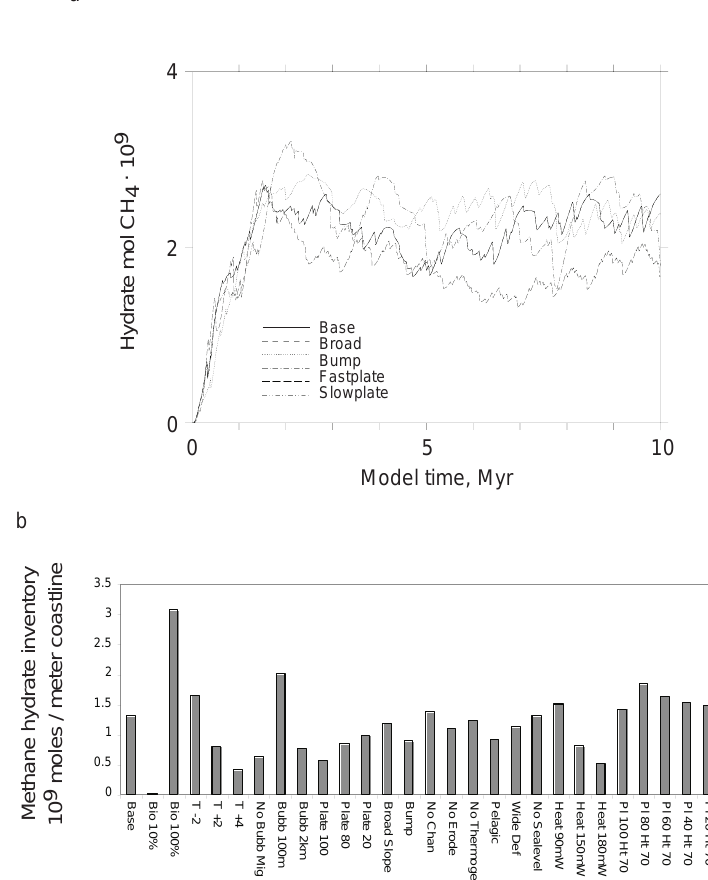
Fig. 16. (a) Time-dependent evolution of the scenarios showing variability due mostly to the coarse grid resolution. (b) Inventory of methane hydrate at the ends of the simulations for all model